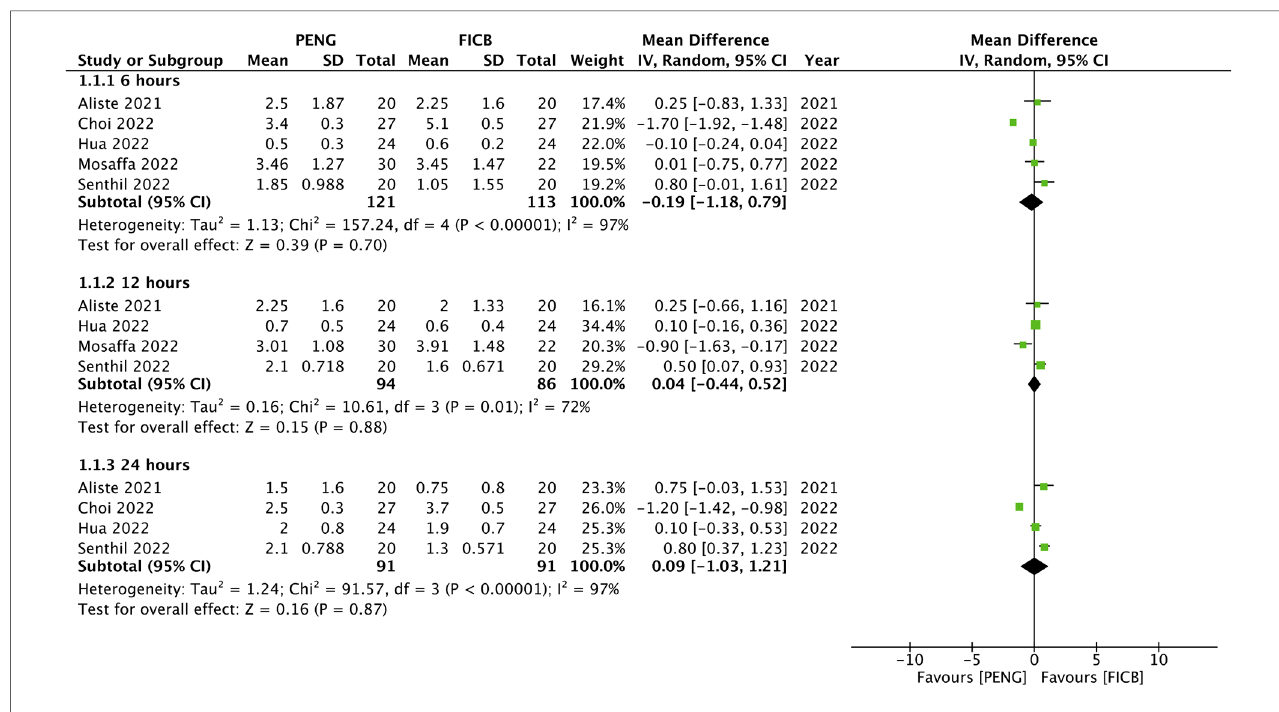
FIGURE 2 Meta-analysis of pain scores at 6 h, 12 h and 24 h between PENG and FICB groups.